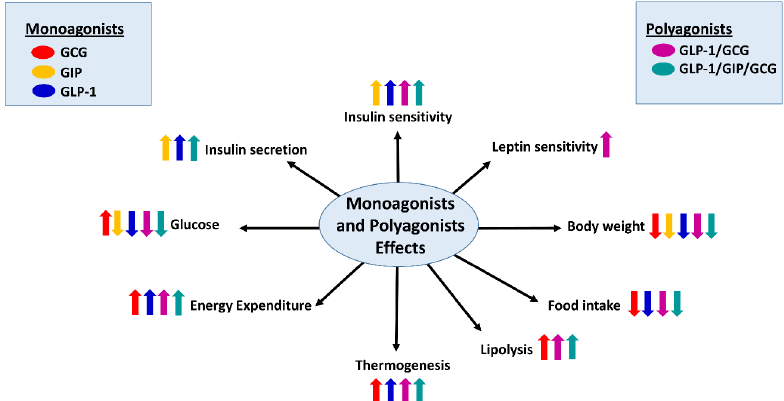
Figure 3. Unimolecular polypharmacy targeting the glucagon receptor: Schematic overview of the effects of polyagonists of glucagon receptor on energy balance regulation. GCG [Glucagon (red)], GIP [glucose insulinotropic peptide (orange)], GLP-1 [Glucagon like peptide-1 (blue)], GLP-1/GCG (purple), and GLP-1/GIP/GCG (green) (right and left panels). Arrows up indicate increase, while arrows down indicate decrease. Figure made with Servier Medical Art resources.